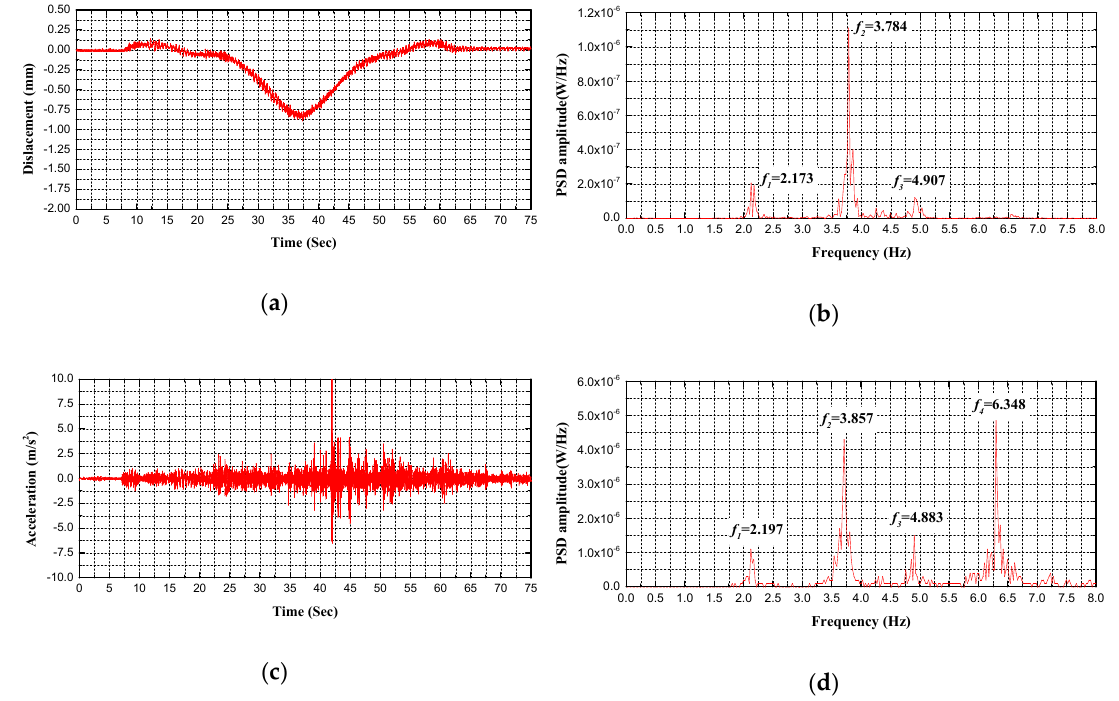
Figure 16. Comparison between measured frequencies for C1 test condition: ( a ) displacement response measured by HVS; ( b ) the PSD of displacement response measured by HVS; ( c ) acceleration signal measured by accelerometer; ( d ) the PSD of acceleration signal measured by accelerometer.